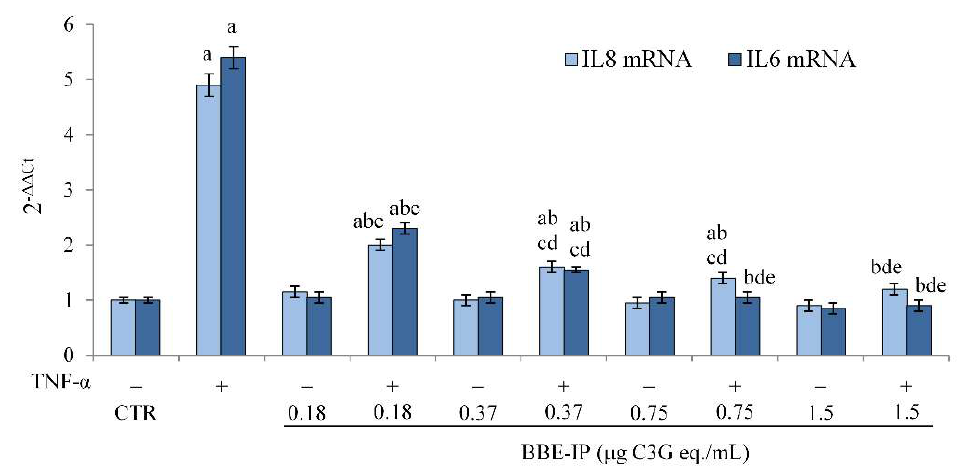
Figure 5. IL-8 and IL-6 mRNA expression. Differentiated Caco-2 cells were pretreated or not for 24 h with different concentrations of the BBE-IP (0.18, 0.37, 0.75, 1.5 µ g C3G eq./mL). Cells were subsequently exposed to 50 ng/mL TNF- α for 6 h. Cells treated with the vehicles alone were used as controls (CTR). IL-6 and IL-8 mRNA expressions were analyzed by real time PCR and data are expressed as 2 − ∆∆ Ct and normalized to CTR. 18S rRNA was used as housekeeping gene; a p < 0.05 vs. CTR; b p < 0.05 vs. TNF- α ; c p < 0.05 vs. all BBE-IP concentrations not exposed to TNF- α ; d p < 0.05 vs. BBE-IP 0.18 µ g C3G eq./mL + TNF- α ; e p < 0.05 vs. BBE-IP 0.37 µ g C3G eq./mL + TNF- α